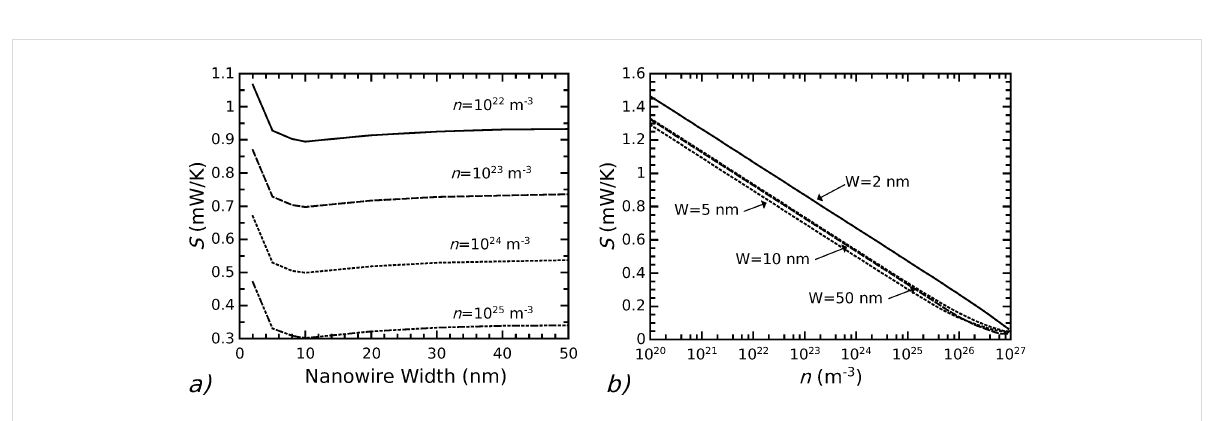
Figure 5: Panel ( a ): Seebeck coefficient in silicon nanowires with triangular cross section as a function of the nanowire width, for different values of n-doping. Panel ( b ): Seebeck coefficient in silicon nanowires as a function of the doping for different nanowire widths. Reproduced with permission from [18], Copyright (2013) AIP publishing